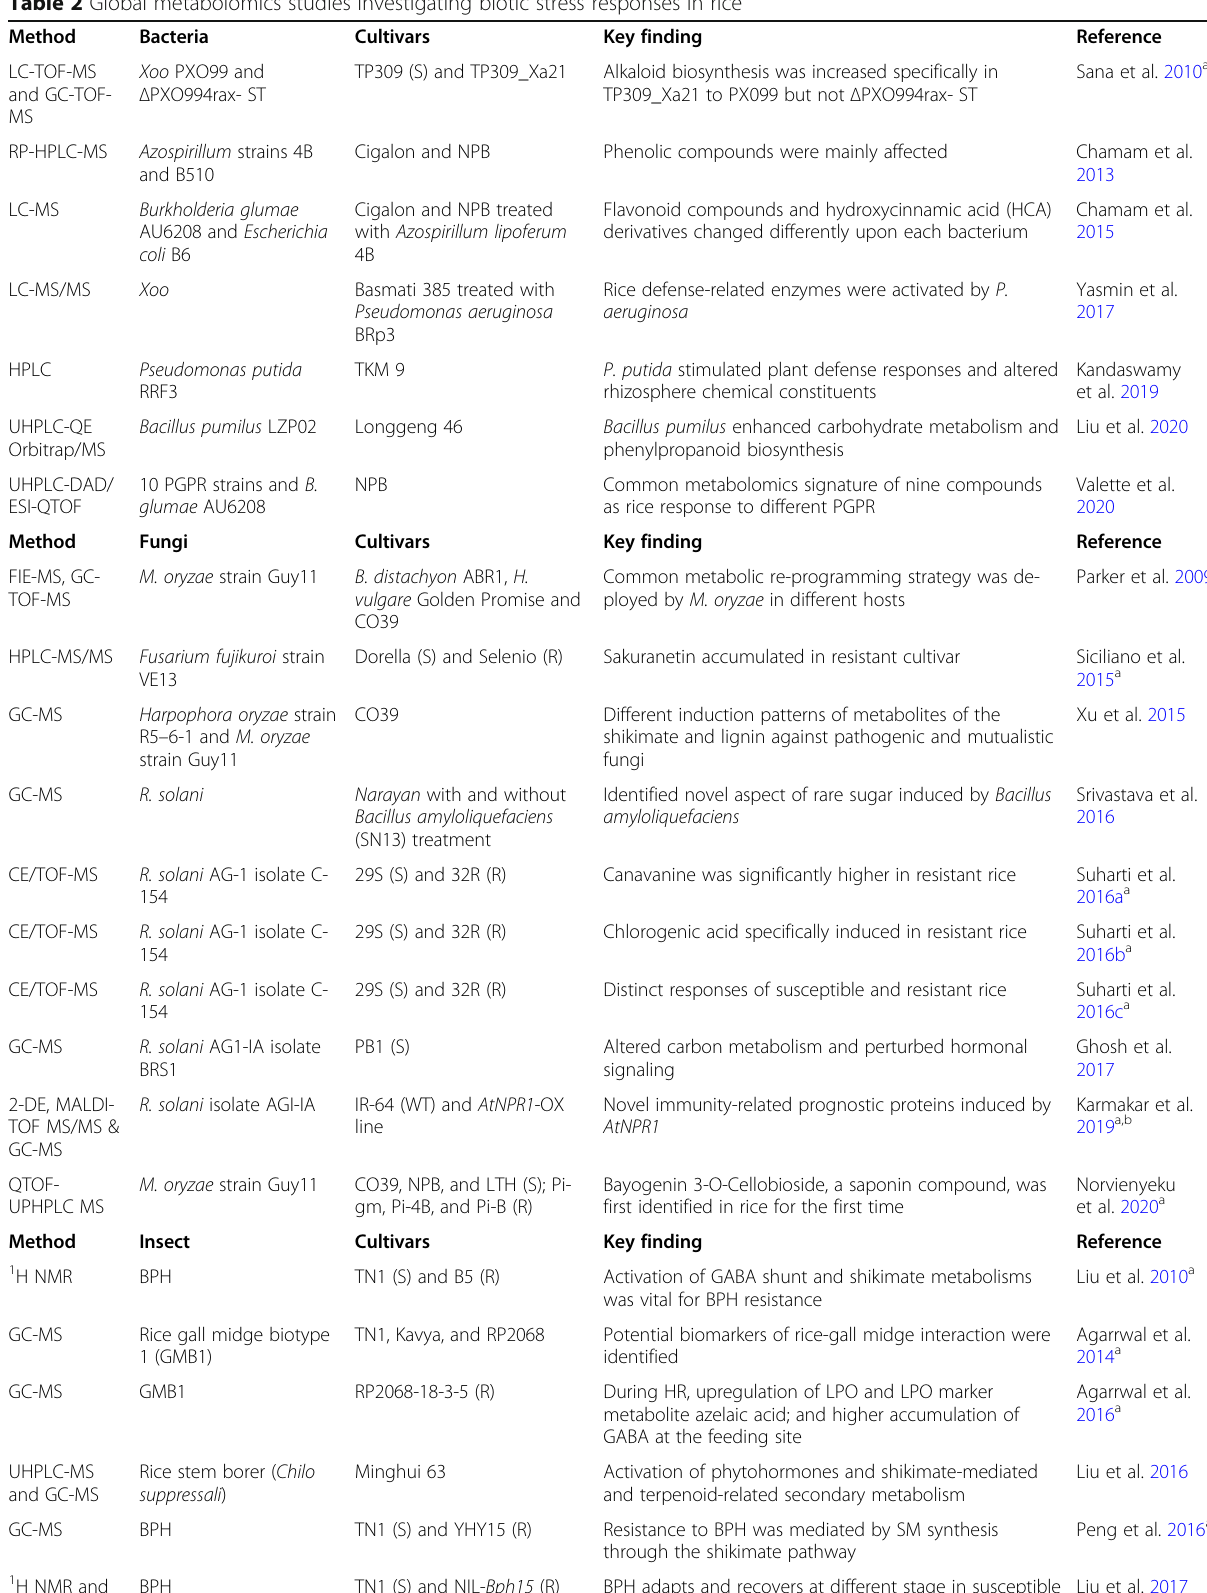
Table 2 Global metabolomics studies investigating biotic stress responses in